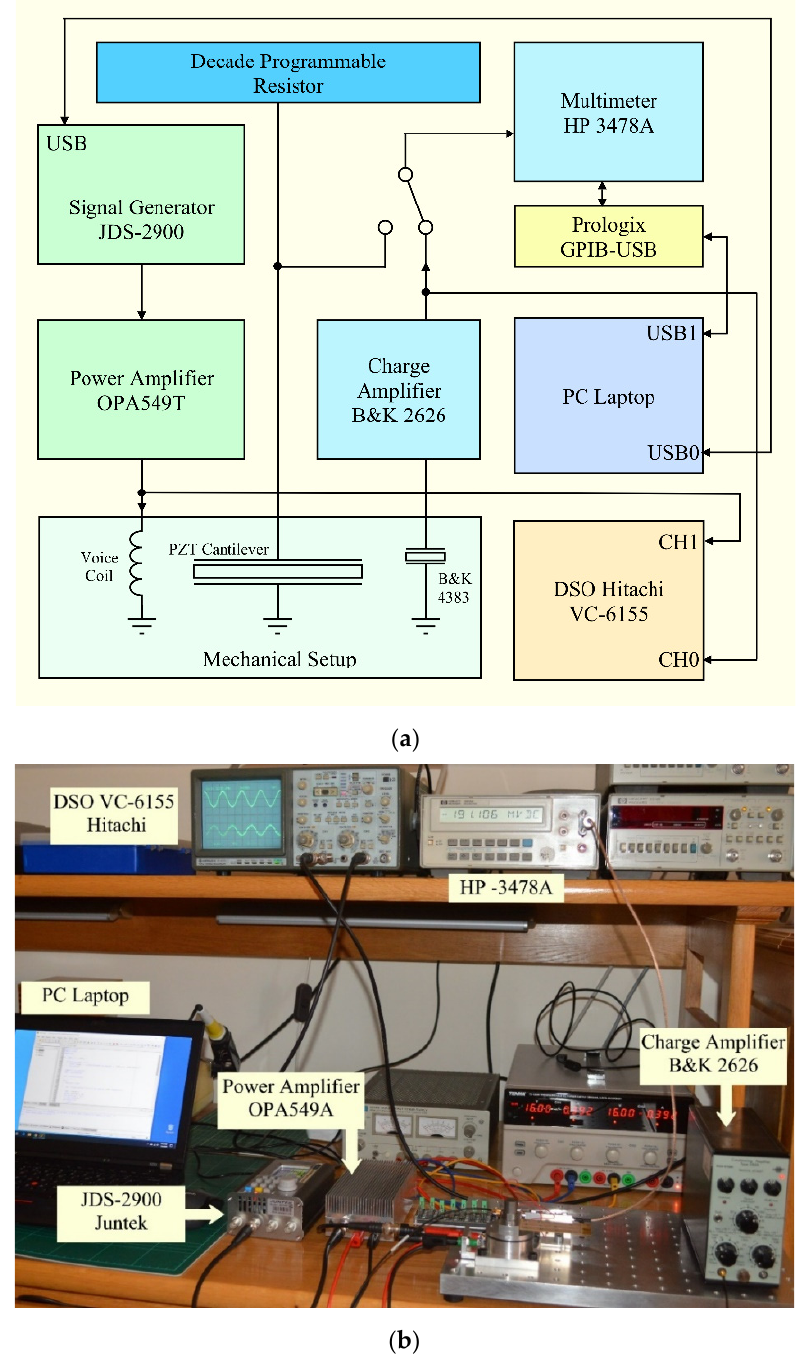
Figure 4. Experimental setup: ( a ) block diagram and ( b ) equipment involved.